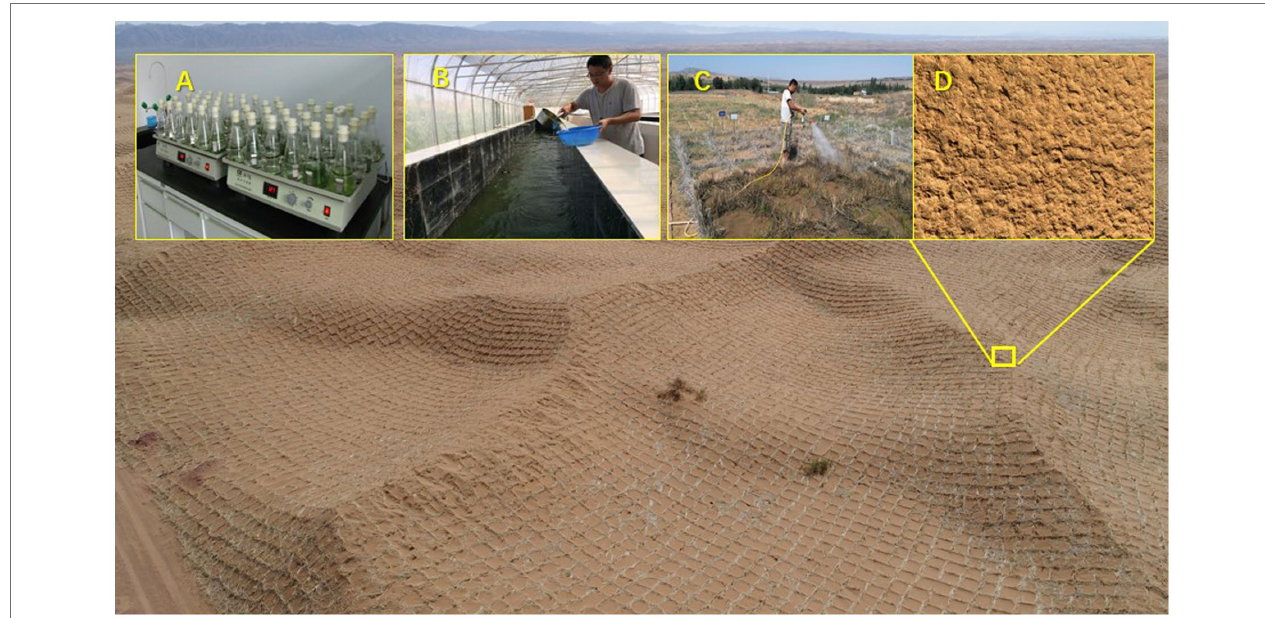
FIGURE 4 | Cultivated non-vascular plants were employed to form biocrusts on dune surface provisionally fixed by the sand barrier using straw checkerboard [ (A) strain isolation and purification; (B) industrial scaled-up cultivation; (C) field spray-inoculation; and (D) cyanobacteria dominated crust after 1 year in the southeastern edge of the Tengger